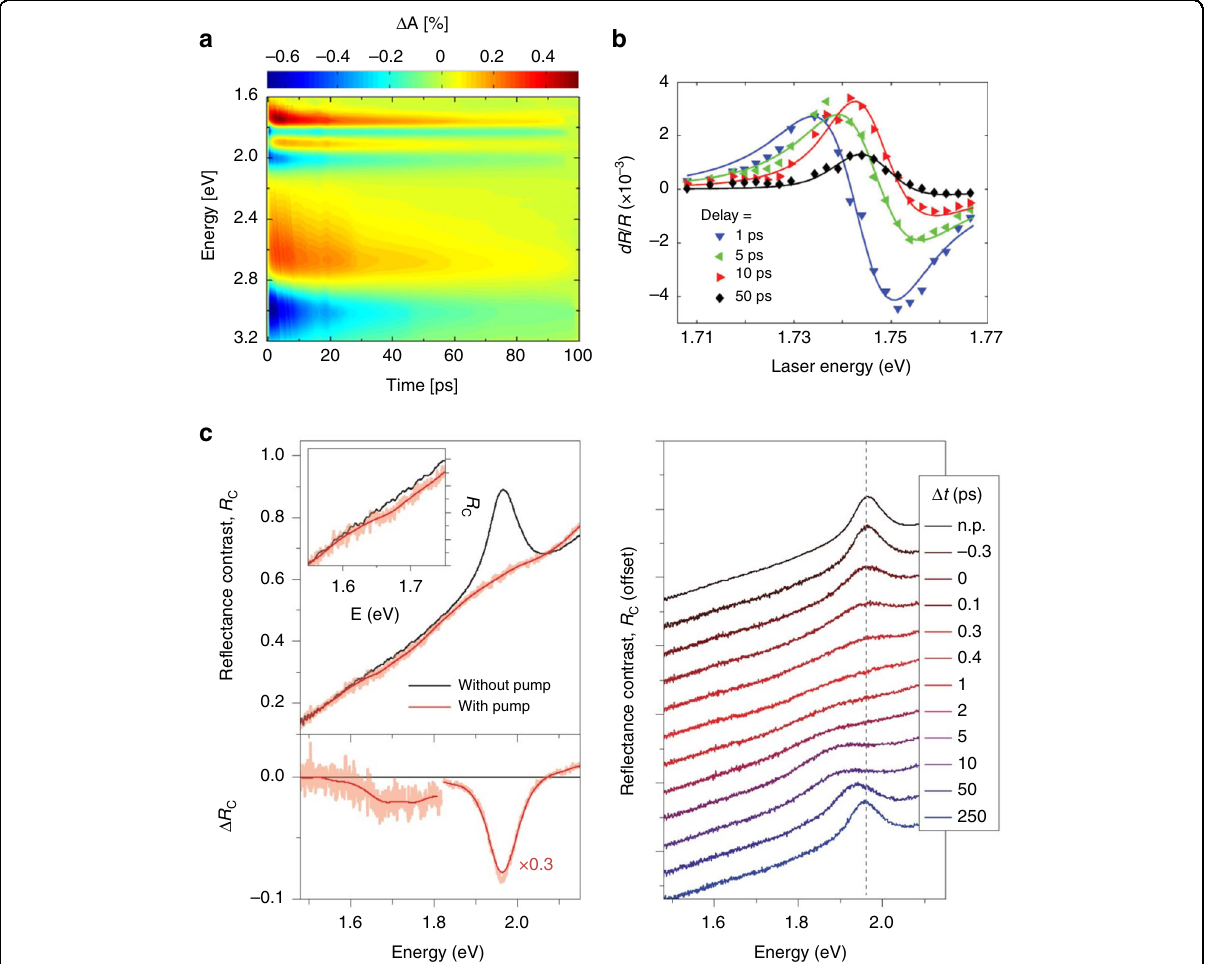
Fig. 3 Screening of Coulomb interactions by charge carriers. a Transient absorption map of monolayer MoS 2 as a function of probe photon energy and pump-probe delay after photoexcitation at 3.10 eV. b d R / R spectra of a WSe 2 monolayer. c Photoinduced optical response of WS 2 bilayers. (Left top) Re fl ectance contrast spectra without pump excitation ( R C,0 ) and 0.4 ps after excitation ( R C ) by a pump pulse with an applied fl uence of 840 μ J/cm 2 . (Left bottom) Corresponding differential re fl ectance contrast spectra Δ R C = R C – R C,0 . (Right) Re fl ectance contrast spectra at different time delays after excitation. Figure reproduced with permission from a ref. 56 , © 2016 American Chemical Society; b ref. 57 , © 2014 IOP Publishing; c ref. 39 , © 2015, Springer